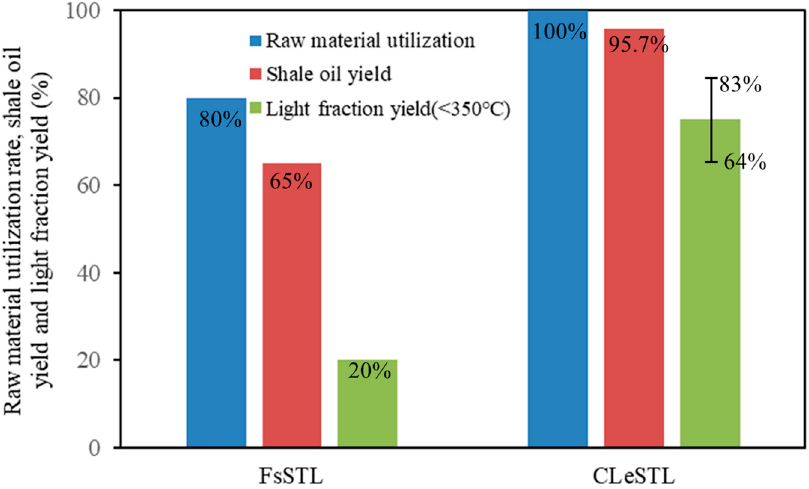
Figure 14. Technical performance comparison of the FsSTL and CLeSTL processes.